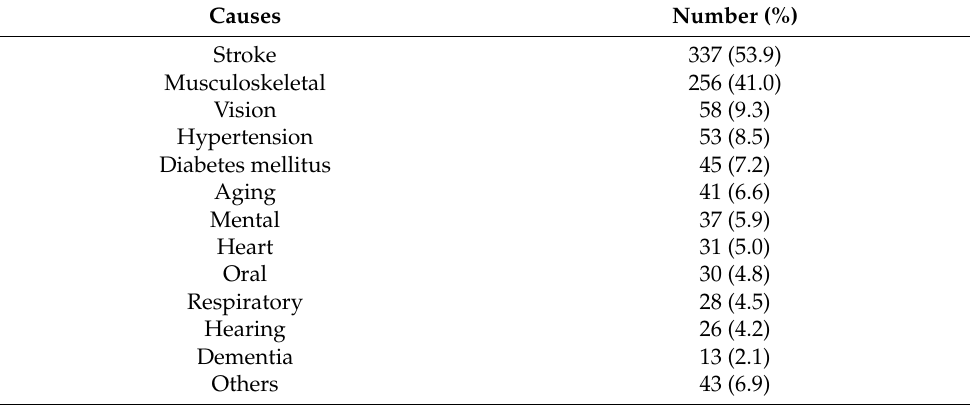
Table 4. Causes of activity limitations reported by stroke survivors (n =